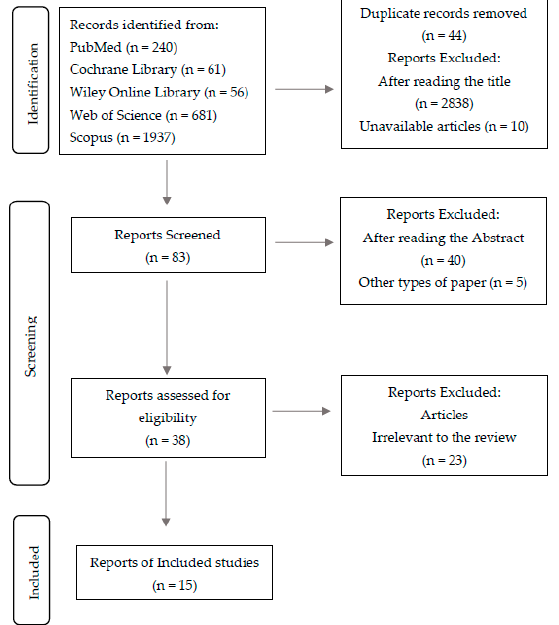
Figure 1. Flow diagram of study selection.